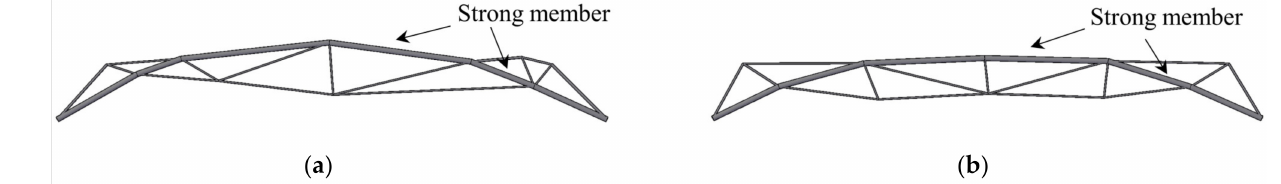
Figure 14. Truss structures for the second student: ( a ) initial result; ( b ) improved result.